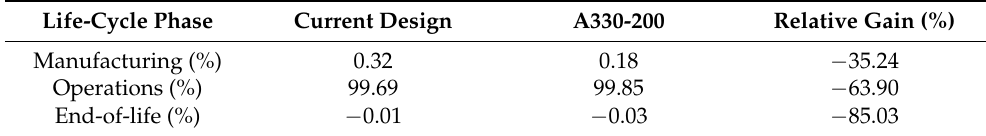
Table 4. ATR contributions from various life-cycle stages Life-Cycle Phase Current